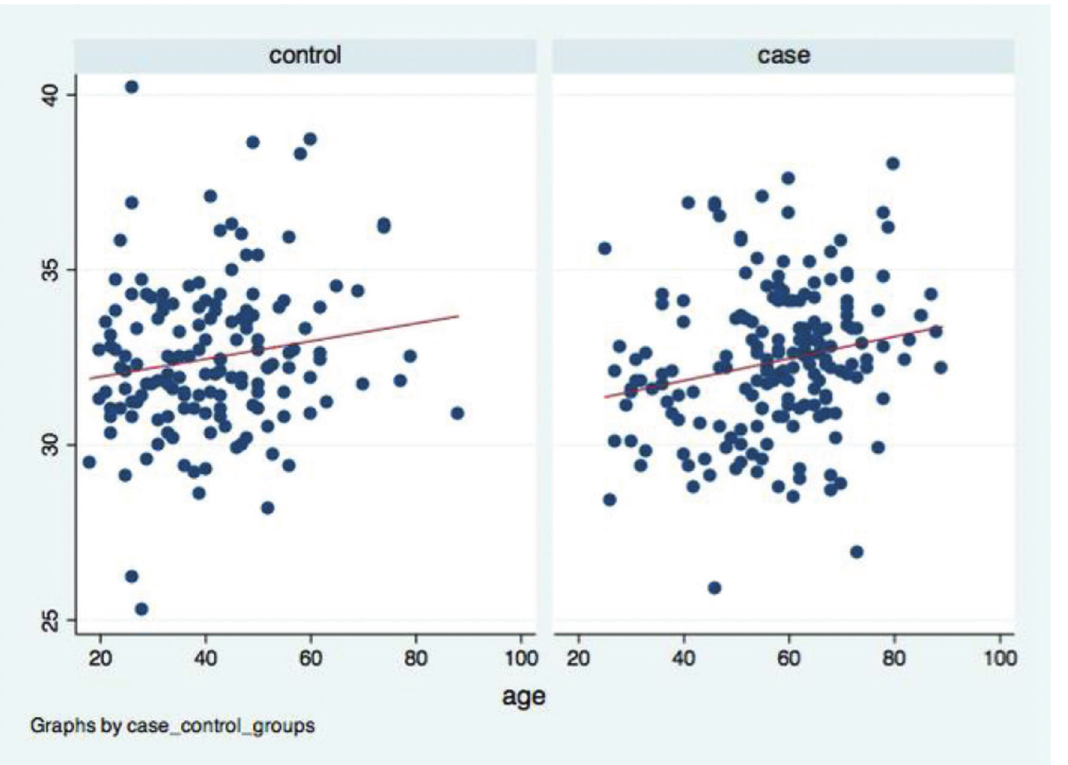
Figure 2 - Dispersion graphic: age versus iliac crest